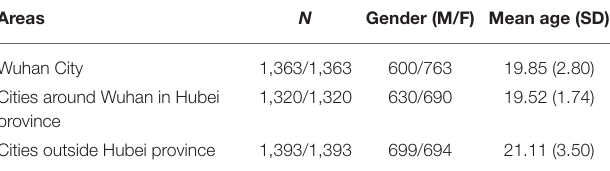
TABLE 6 | Description of samples in three areas.